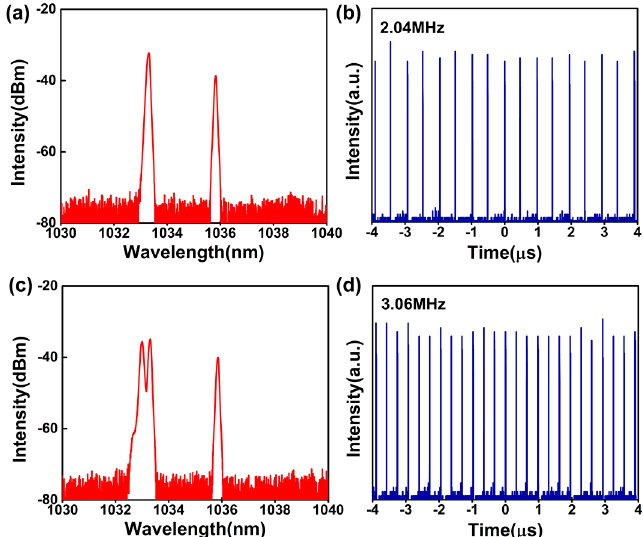
Figure 6. Experimental results for high-order mode-locked pulse: 2nd order ( a ) spectrum and ( b ) pulse train; and 3rd order ( c ) spectrum and ( d ) pulse train.